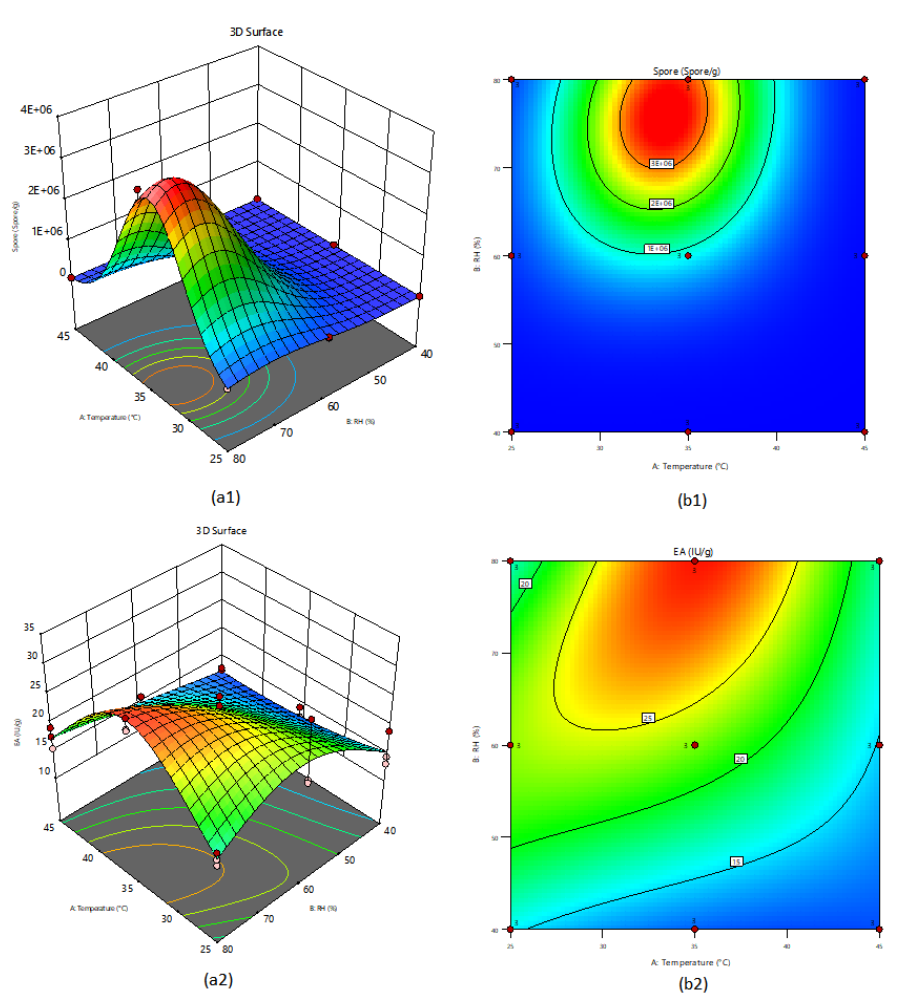
Figure 3. 3D and contour plots for the quadratic models of the transformed responses expressed by Equations (2) and (3) for spore count (upper) and Enzymatic Activity (lower), respectively. ( a1 , a2 ) 3D plots for spore count and enzyme activity, respectively. ( b1 , b2 ) Contour plots for spore count and enzyme activity, respectively.